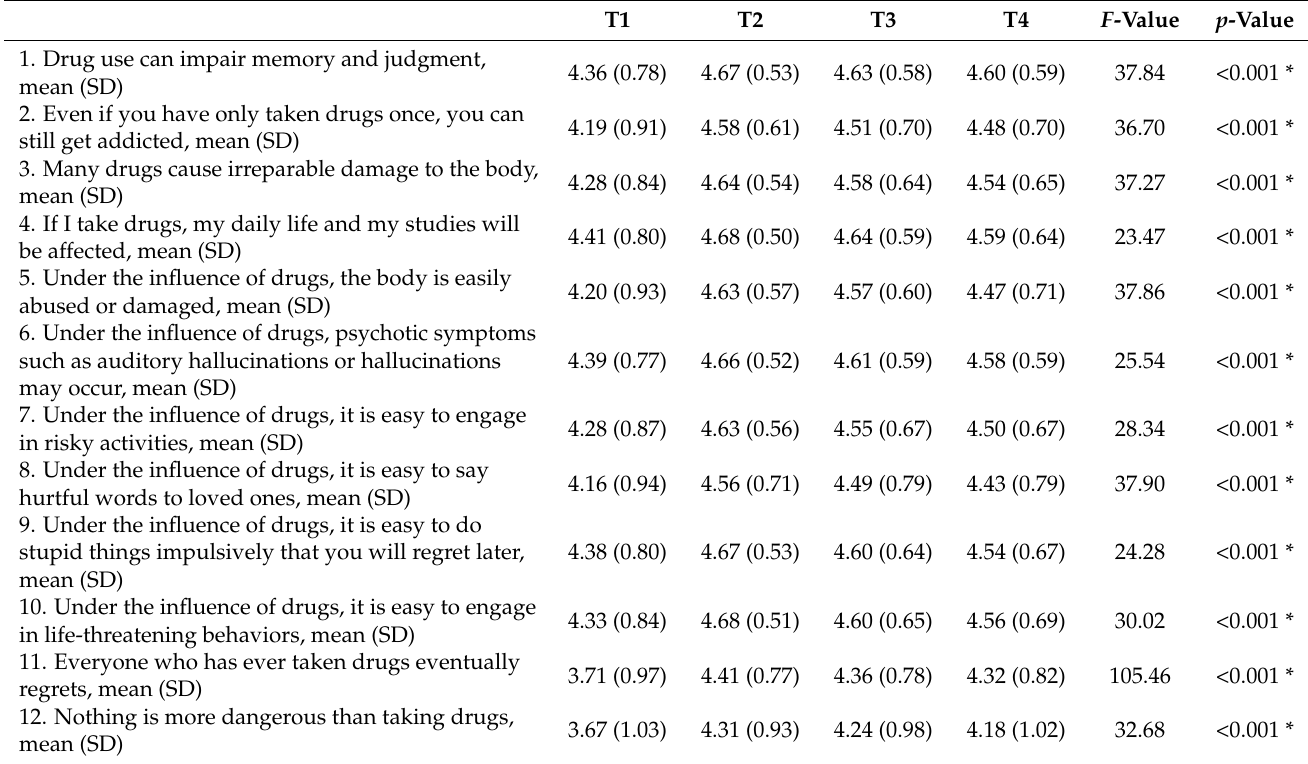
Table 3. Change in attitudes towards drug abuse among anti-drug ambassadors by repeated-measures ANOVA ( n = 198). T1 T2 T3 T4 F